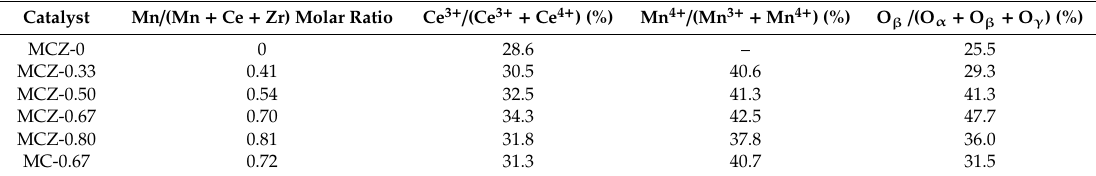
Figure 4. X-ray photoelectron spectroscopy (XPS) spectra of Ce 3d ( A ); Mn 2p ( B ); O 1s ( C ) and Zr 3d ( D ) of MCZ-x (x = 0, 0.33, 0.50, 0.67, 0.80) and MC-0.67 catalysts. Table 2. XPS results of MCZ-x (x = 0, 0.33, 0.50, 0.67, 0.80) and MC-0.67 catalysts.